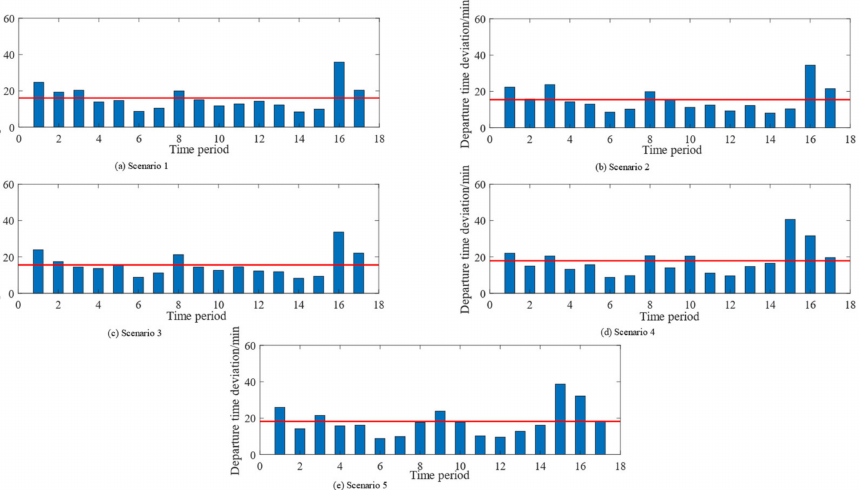
Figure 13. The passenger departure time deviation in each time period under each demand scenario.